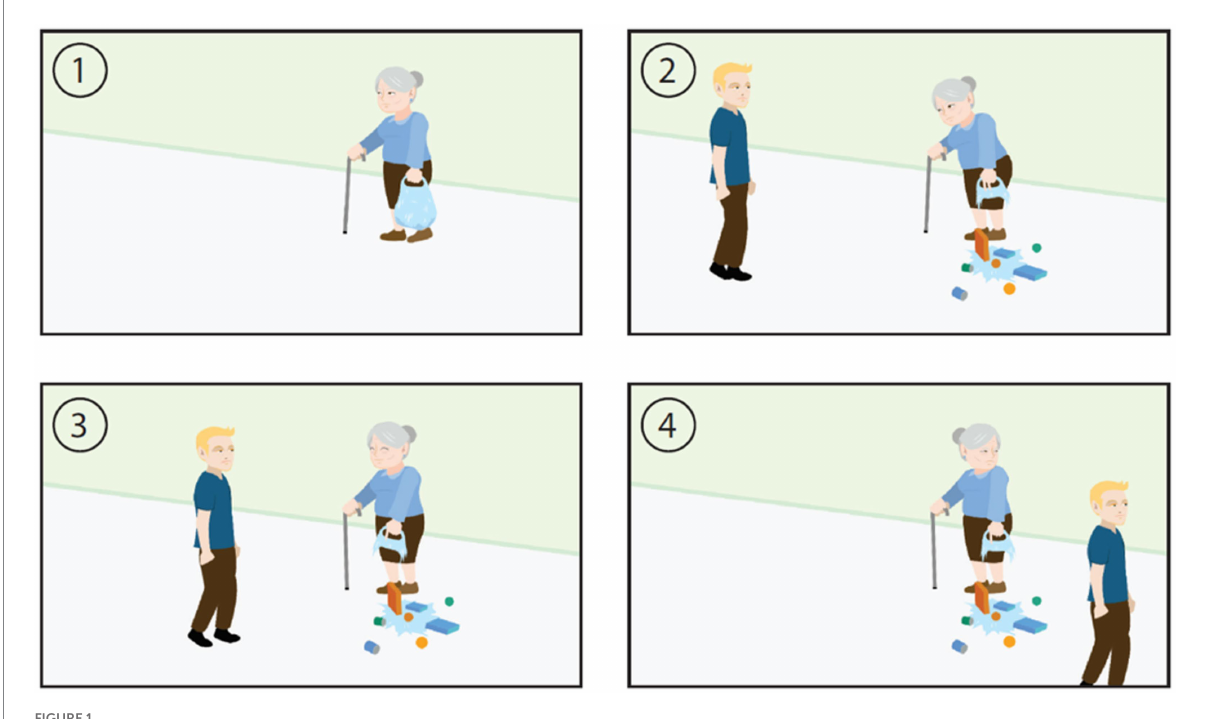
FIGURE 1 An example interaction of